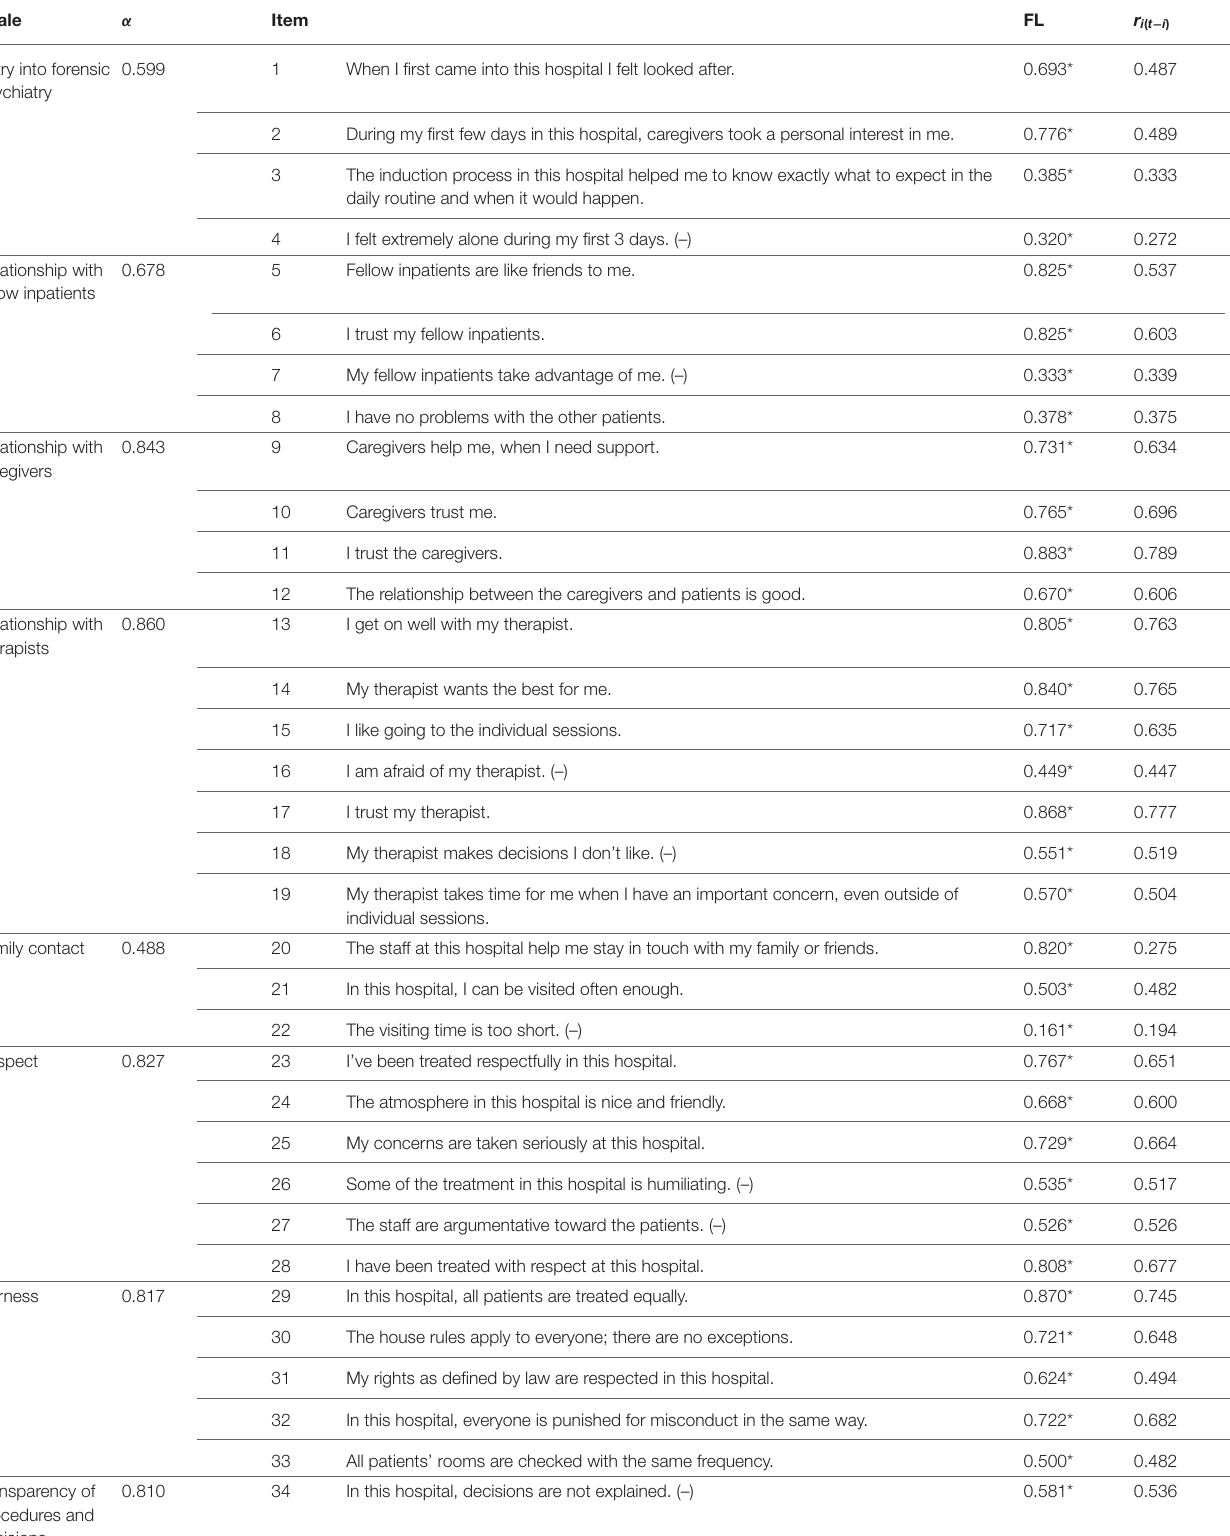
TABLE 2 | Item characteristics and reliabilities of the adapted measuring the quality of prison life questionnaire.